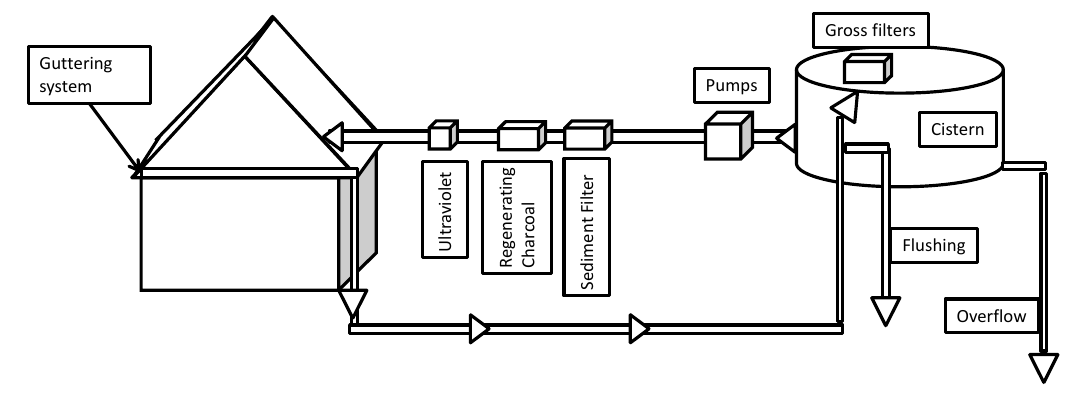
Figure 5 . Rainwater harvesting system as designed . Figure 5. Rainwater harvesting system as